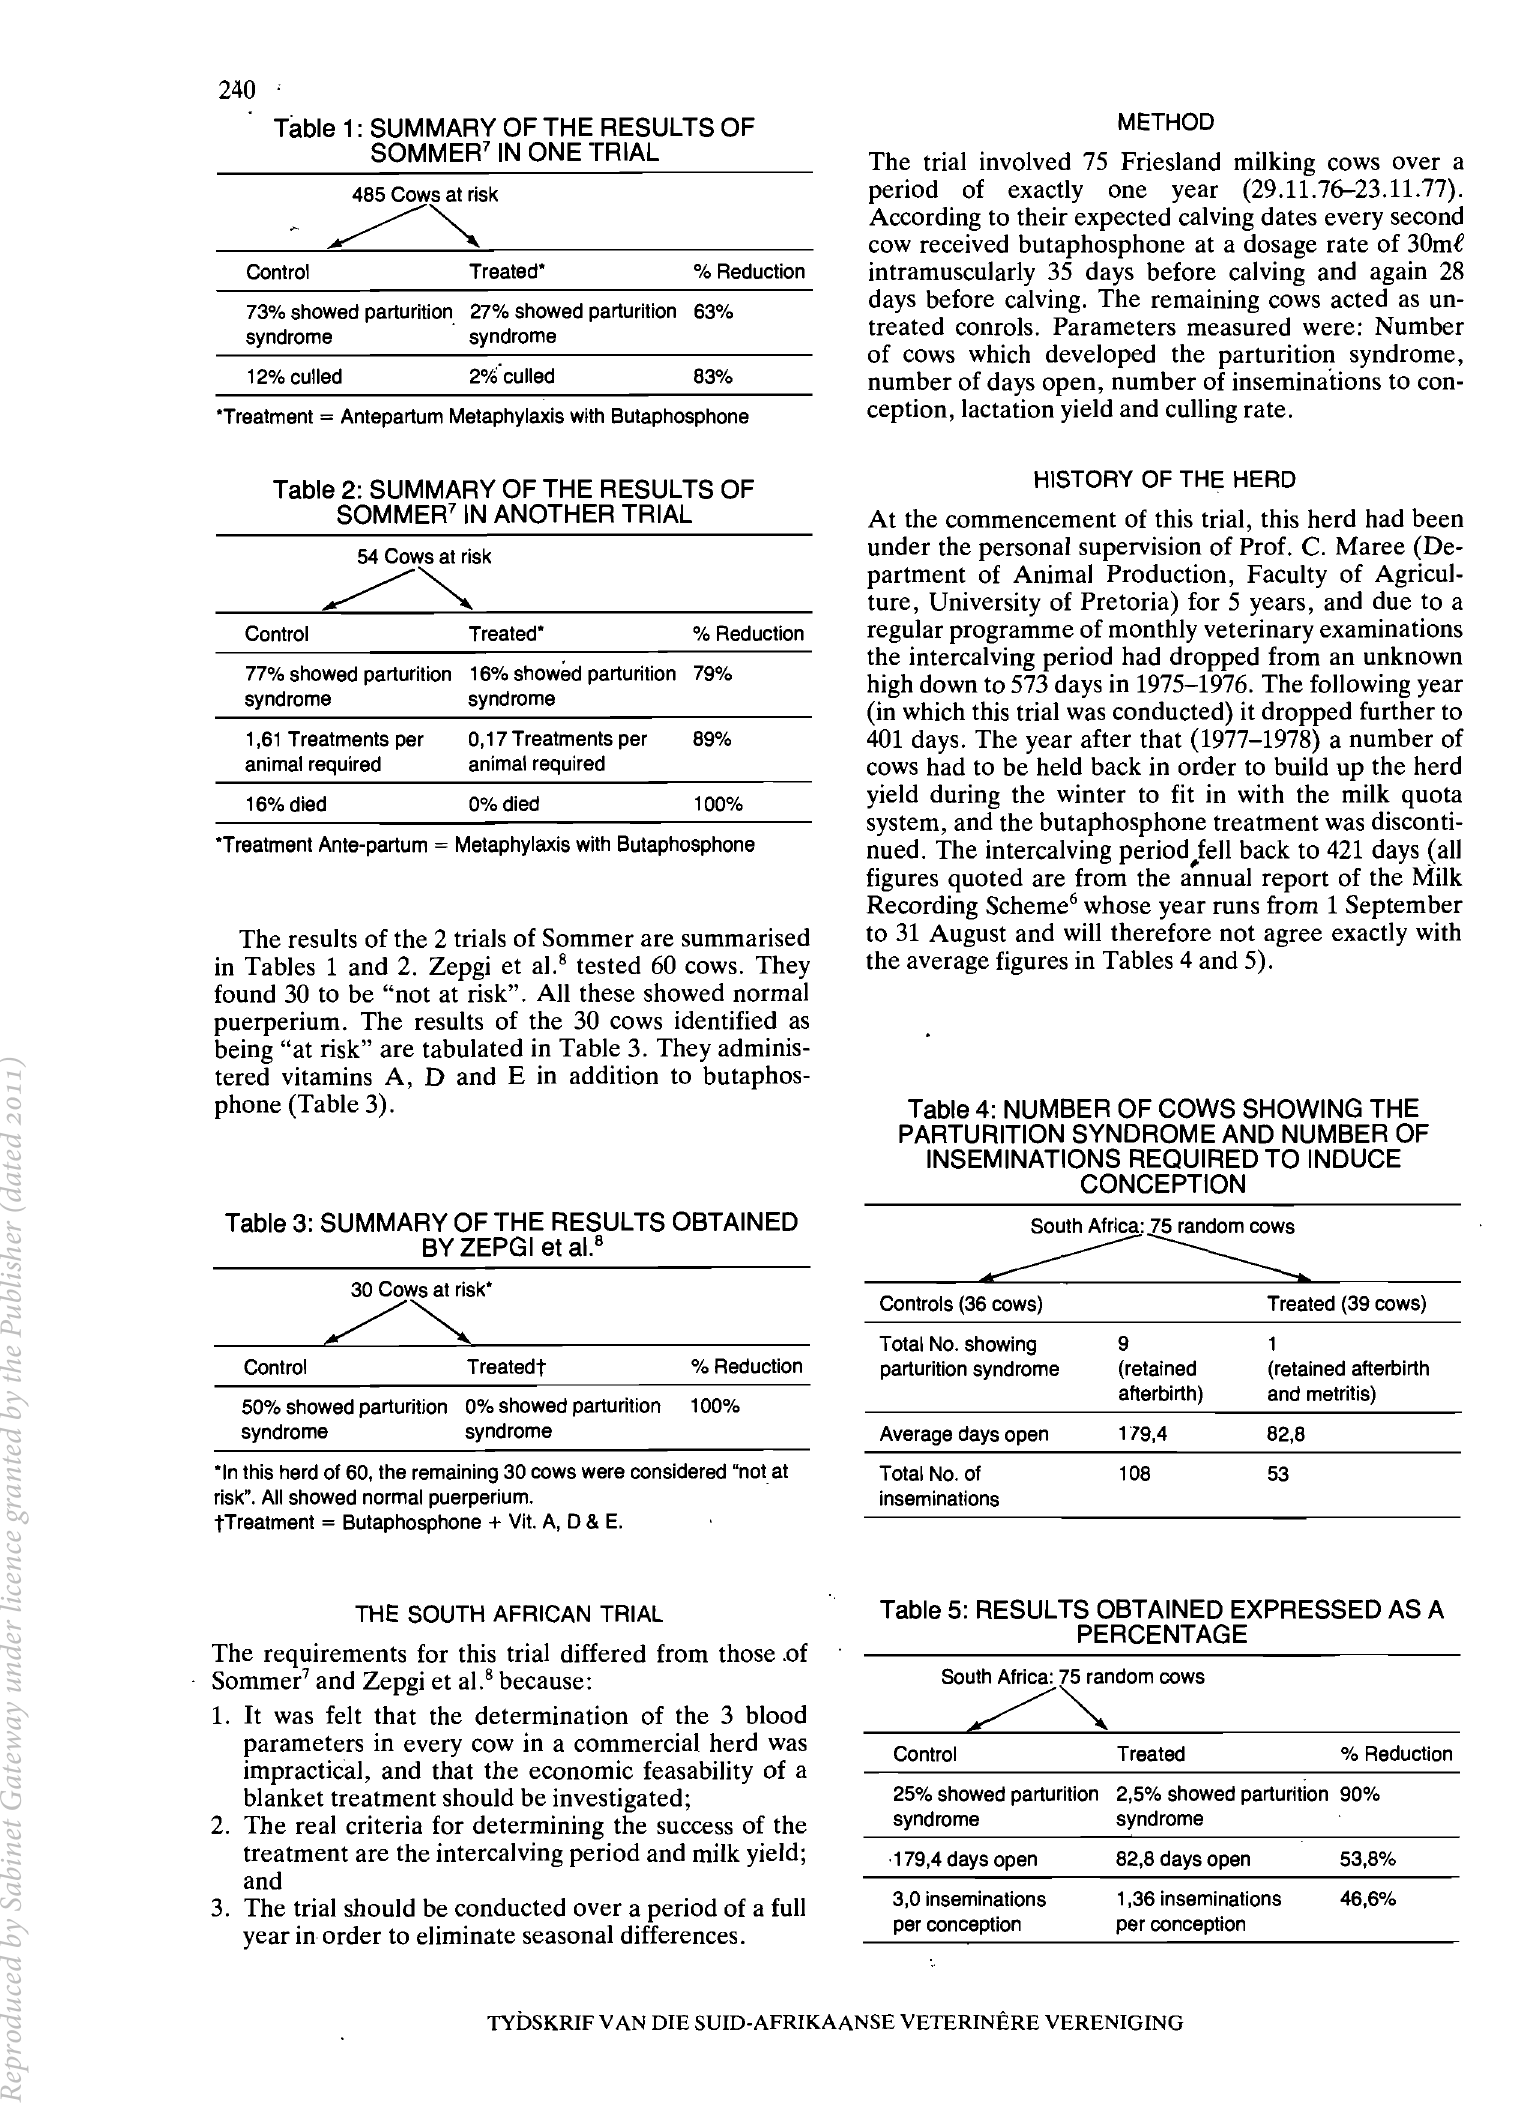
Table 1: SUMMARY OF THE RESULTS OF SOMMER 7 IN ONE TRIAL 485 Cows at risk